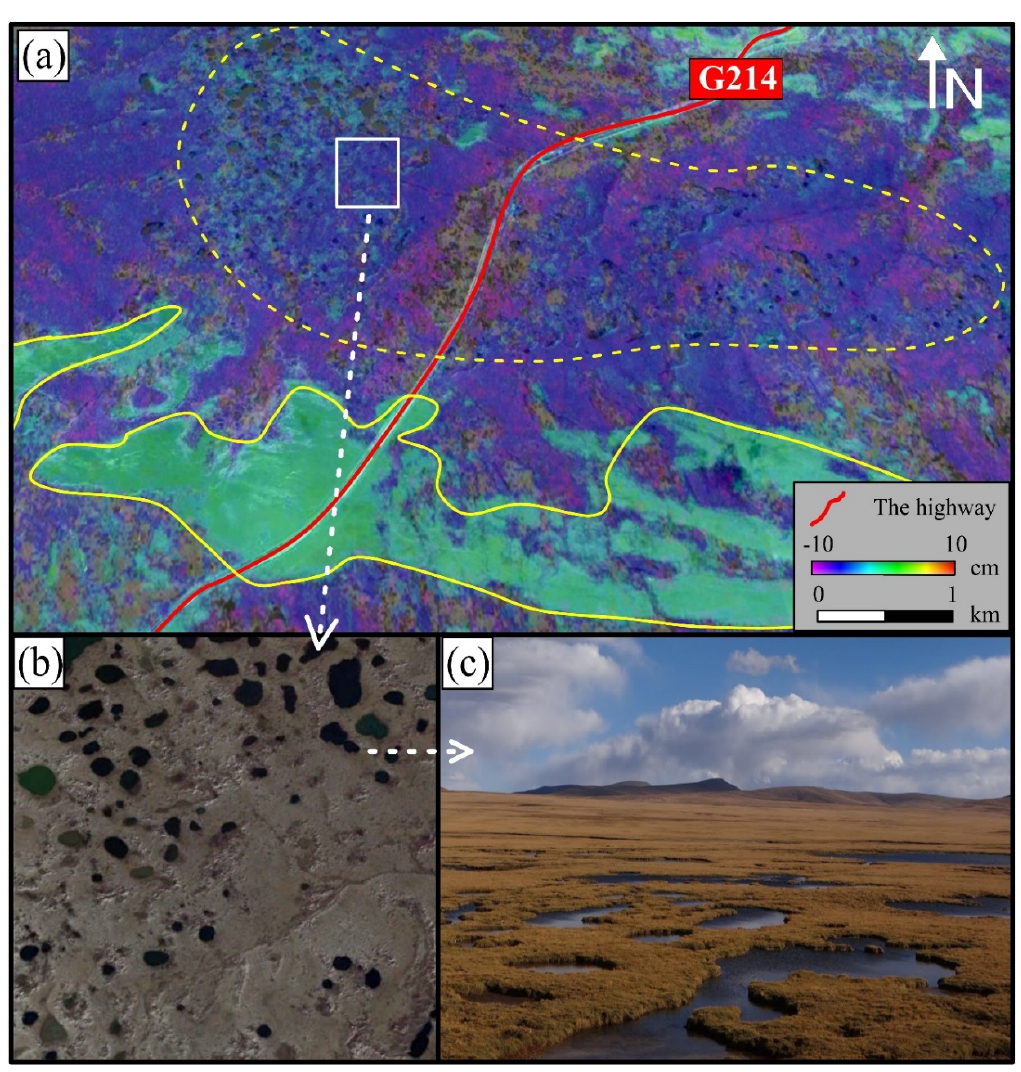
Figure 6. ( a ) The detailed subsidence distribution on region A; ( b ) High resolution optical satellite image from Google Earth; ( c ) Photos on ‐ site from Google Earth.